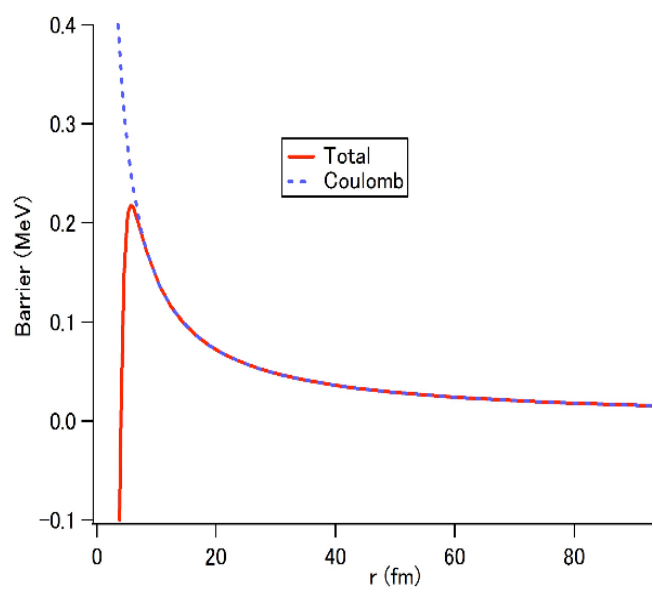
Figure 3. Potential and Coulomb barrier of normal nuclei.